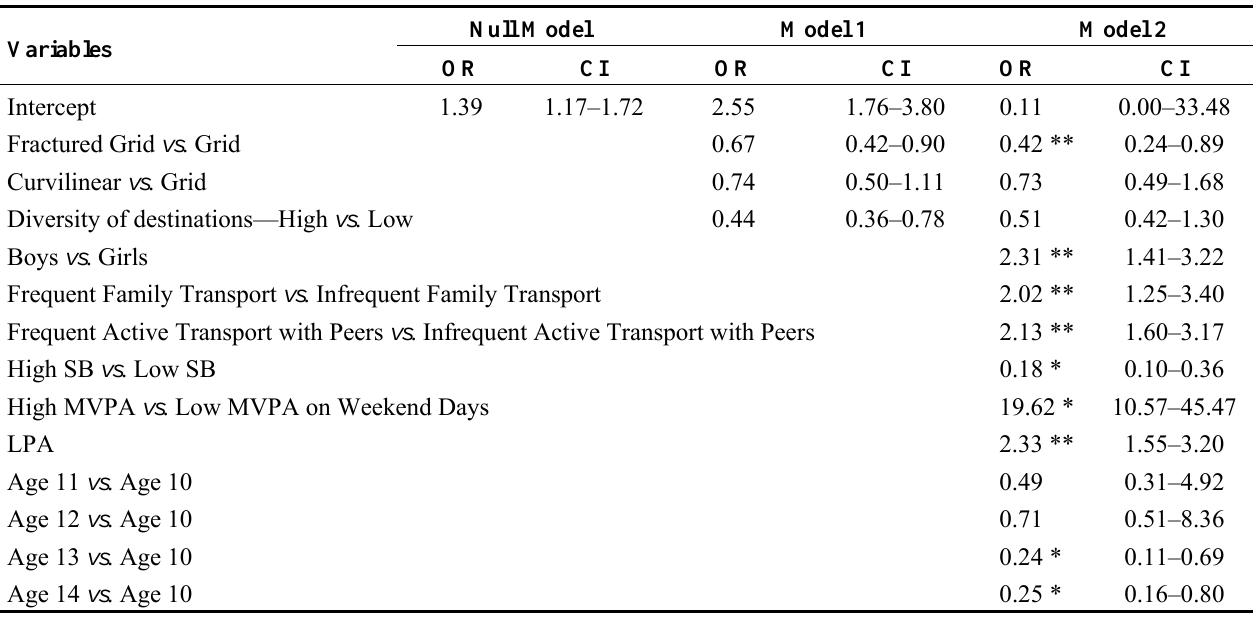
Table 3. Multilevel logistic regression model predicting MVPA accumulation (mean daily MVPA ≥ 60 vs. <60